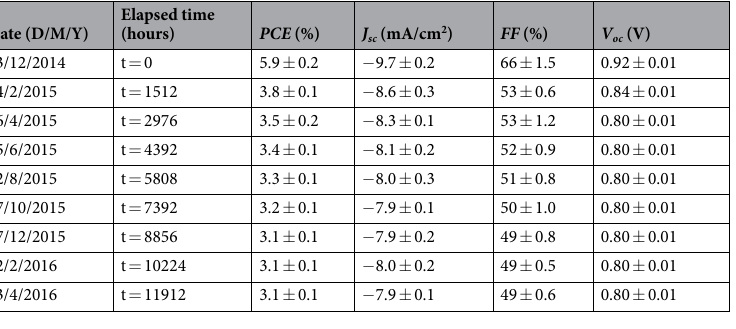
Table 1. Devices metrics measured in laboratory for devices undergoing outdoor lifetime